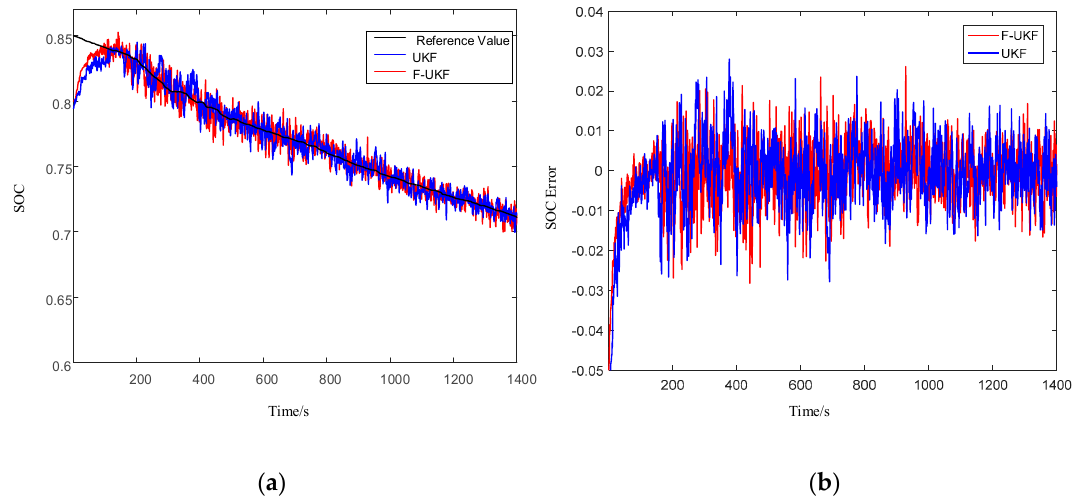
Figure 11. ( a ) SOC estimation curve of urban dynamometer driving schedule (UDDS) driving cycles based on the F-UKF and UKF algorithms. ( b ) SOC estimation error curve of UDDS driving cycles based on the F-UKF and UKF algorithms.